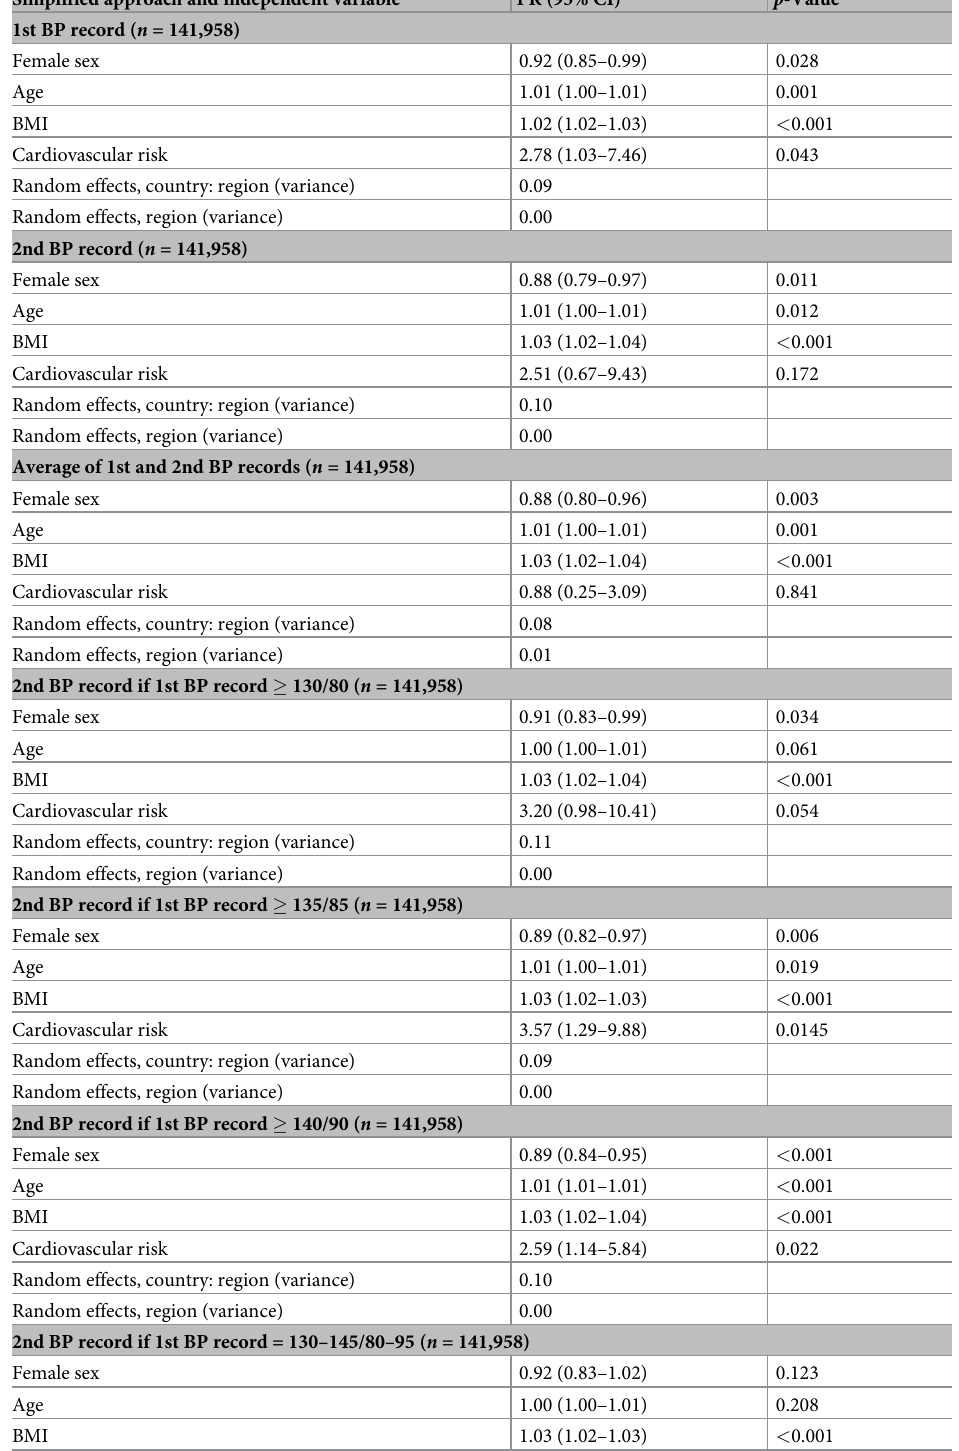
Table 4. Multilevel regression models for missed hypertension diagnosis according to the 9 simplified BP screen- ing